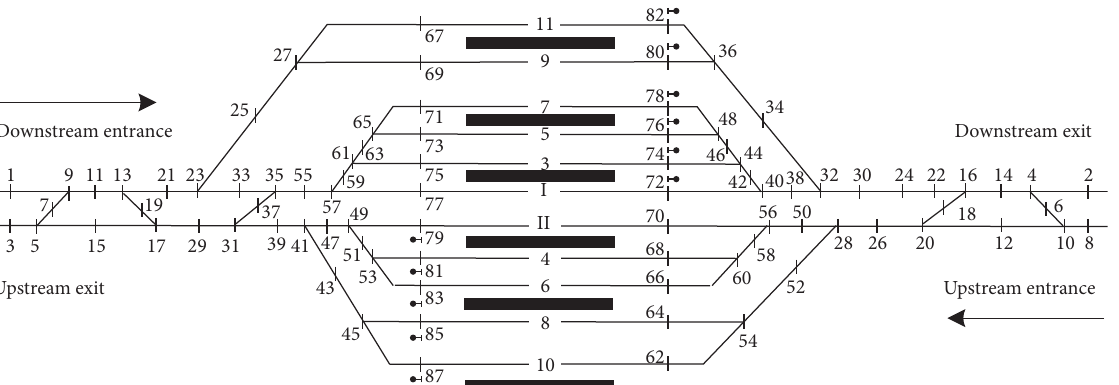
Figure 7: Layout of the railway passenger station. Table 3: Initial platform tack assignment plan between 16:00 and 22:00.